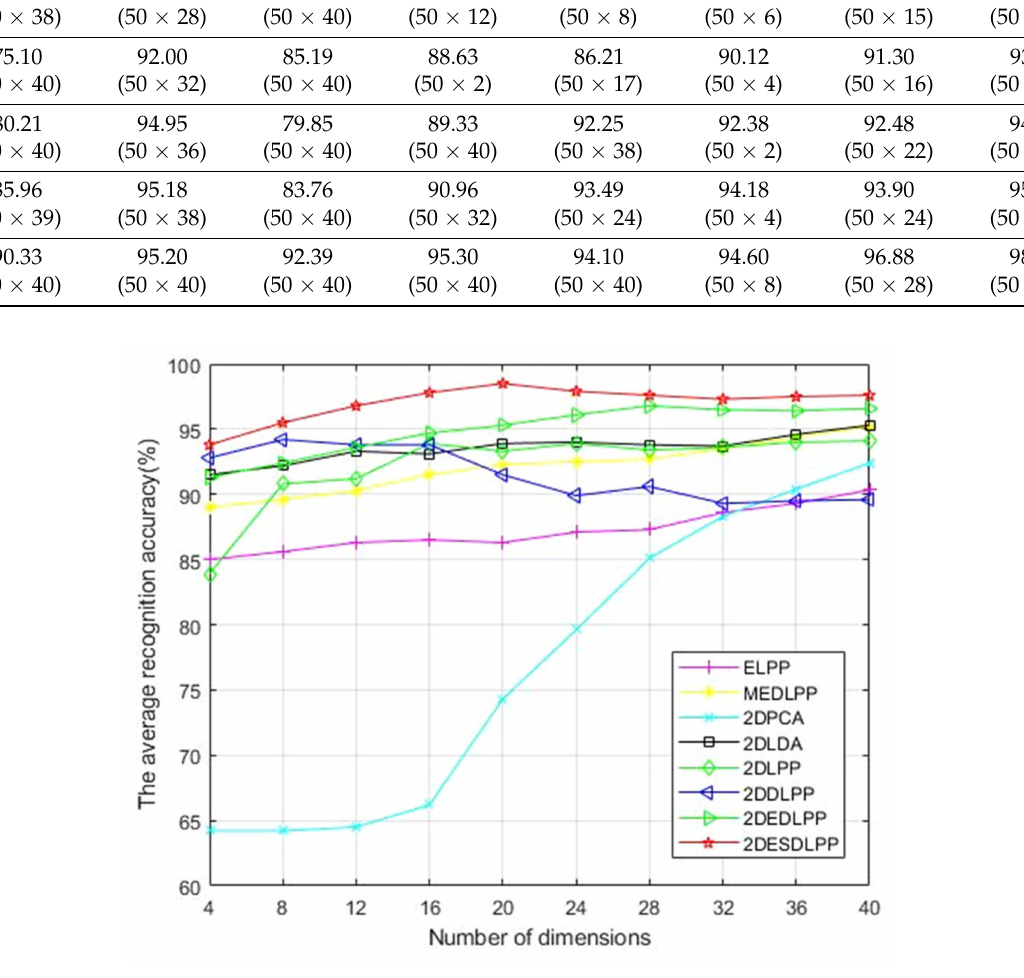
Figure 6. Average recognition rate (%) with feature dimension for different algorithms when the number of training samples in the ORL face database is